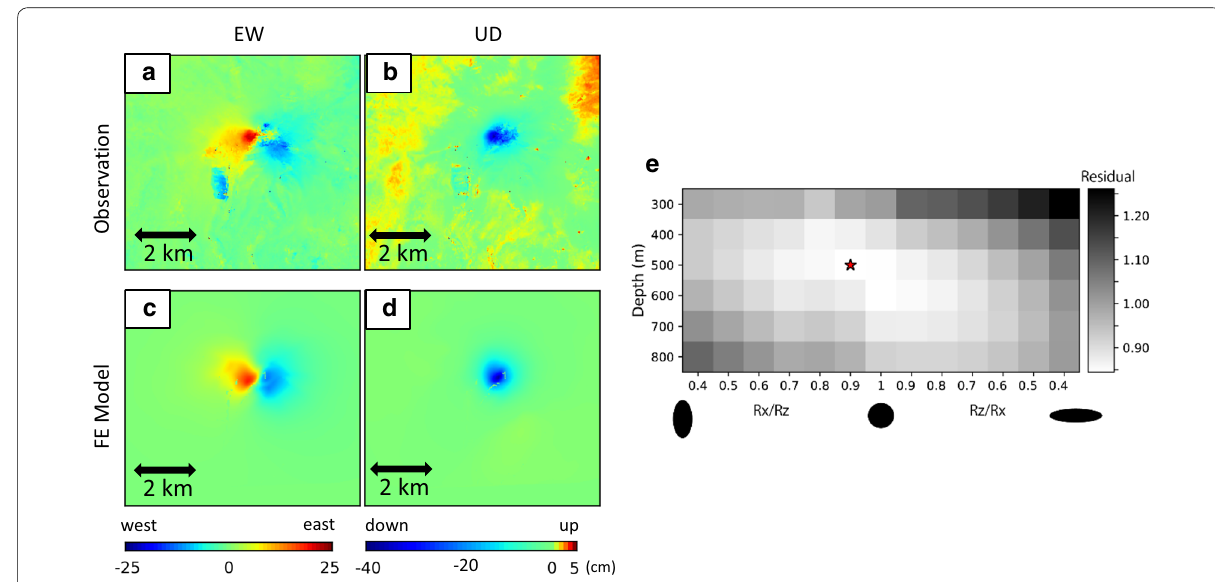
Fig. 5 Results of FEM modeling for the area in Fig. 1 inset. a , b Observations of the EW and UD component are the same as those presented in Fig. 4a, c, respectively. c , d Synthesized distributions for the corresponding components based on the best-fit model. e Residual distribution for combinations of the free parameters, that is, the aspect ratio of the spheroidal source (abscissa: ratio of the minor axis to the major axis with typical shape schematics) and the depth (ordinate). In the left half of the chart, the aspect ratio is represented as a ratio of the horizontal axis to the vertical axis and the shape is characterized as prolate (vertically elongated), whereas in the right half of the chart, the ratio is for the horizontal axis to the vertical axis and the shape is oblate. The residuals are colored in grayscale. A red star indicates the best-fit combination of the